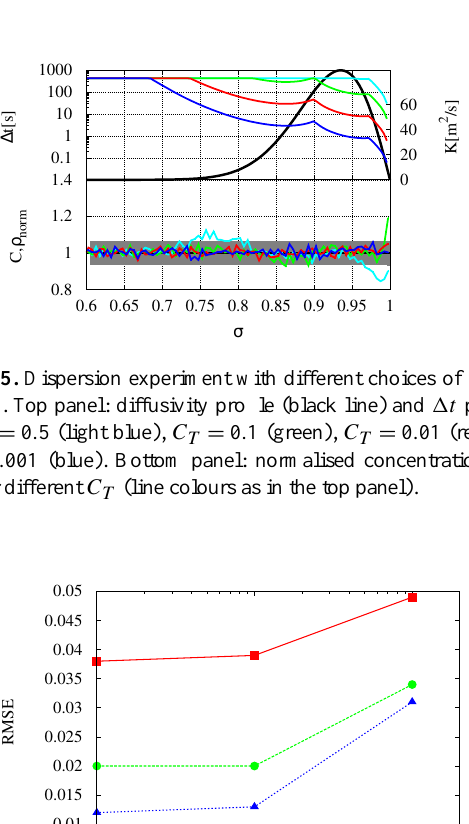
Fig. 5. Dispersion experiment with different choices of parame- ter C T . Top panel: diffusivity profile (black line) and ∆ t profiles for C T = 0 . 5 (light blue), C T = 0 . 1 (green), C T = 0 . 01 (red) and C T = 0 . 001 (blue). Bottom panel: normalized concentration pro- files for different C T (Line colors as in the top panel).